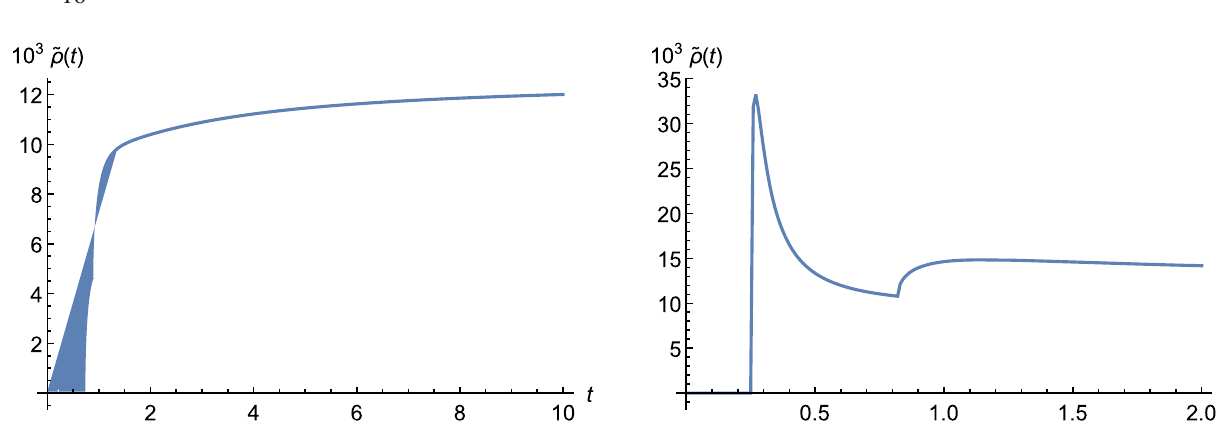
Fig. 6 Spectral function for the two-point correlation function (cid:2) O ( p ) O ( − p ) (cid:3) , with t given in units of μ 2 , for the Region I (left) and Region II (right) with parameter values given in Table